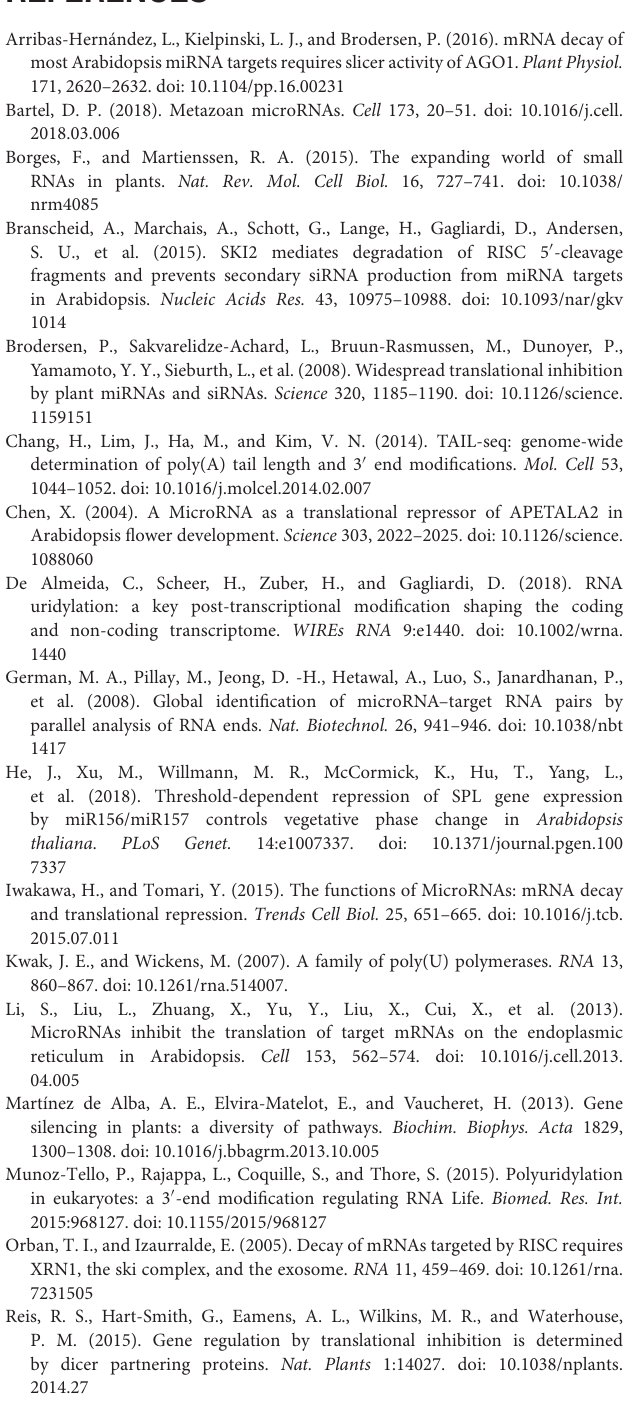
DATA SHEET S1 | Scripts for 3 (cid:48) RACE-seq data processing, related to the analysis of 5 (cid:48) mRNA fragments generated by RISC cleavage of MYB33